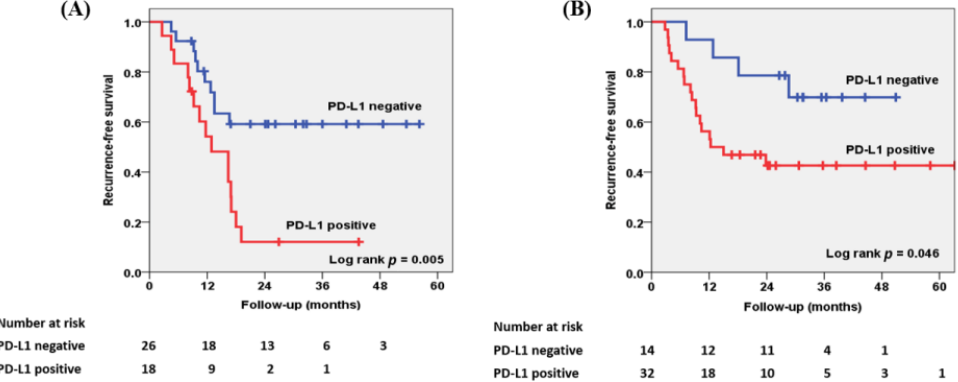
Figure 3. Kaplan–Meier survival curves for RFS according to PD-L1 expression in TICs in patients with ( A ) MPUC and ( B ) UCSD. For patients with MPUC, the two-year overall RFS rate was significantly ( p = 0.005) shorter in patients with positive expression of PD-L1 in TICs than in those with negative expression of PD-L1 in TICs (12.0% and 63.4%, respectively). Similarly, for patients with UCSD, PD-L1 expression in TICs also significantly ( p = 0.046) affected the two-year overall RFS rate, which was 78.6% in patients with negative PD-L1 expression in TICs and 42.6% in PD-L1-positive patients. Table 3 summarizes the multivariable Cox proportional hazard regression analysis for predicting tumor recurrence after RC. A locally advanced tumor stage more than ≥ pT3, LN involvement and LVI (only for patients with MPUC, all p < 0.05), and positive PD-L1 in TICs were also significantly associated with an increased risk of tumor recur- rence both in patients with MPUC (hazard ratio (HR) = 1.85; 95% confidence interval (CI): 1.323 – 2.672; p = 0.017), and in patients with MPUC (HR = 1.58; 95% CI: 1.162 – 2.780; p =